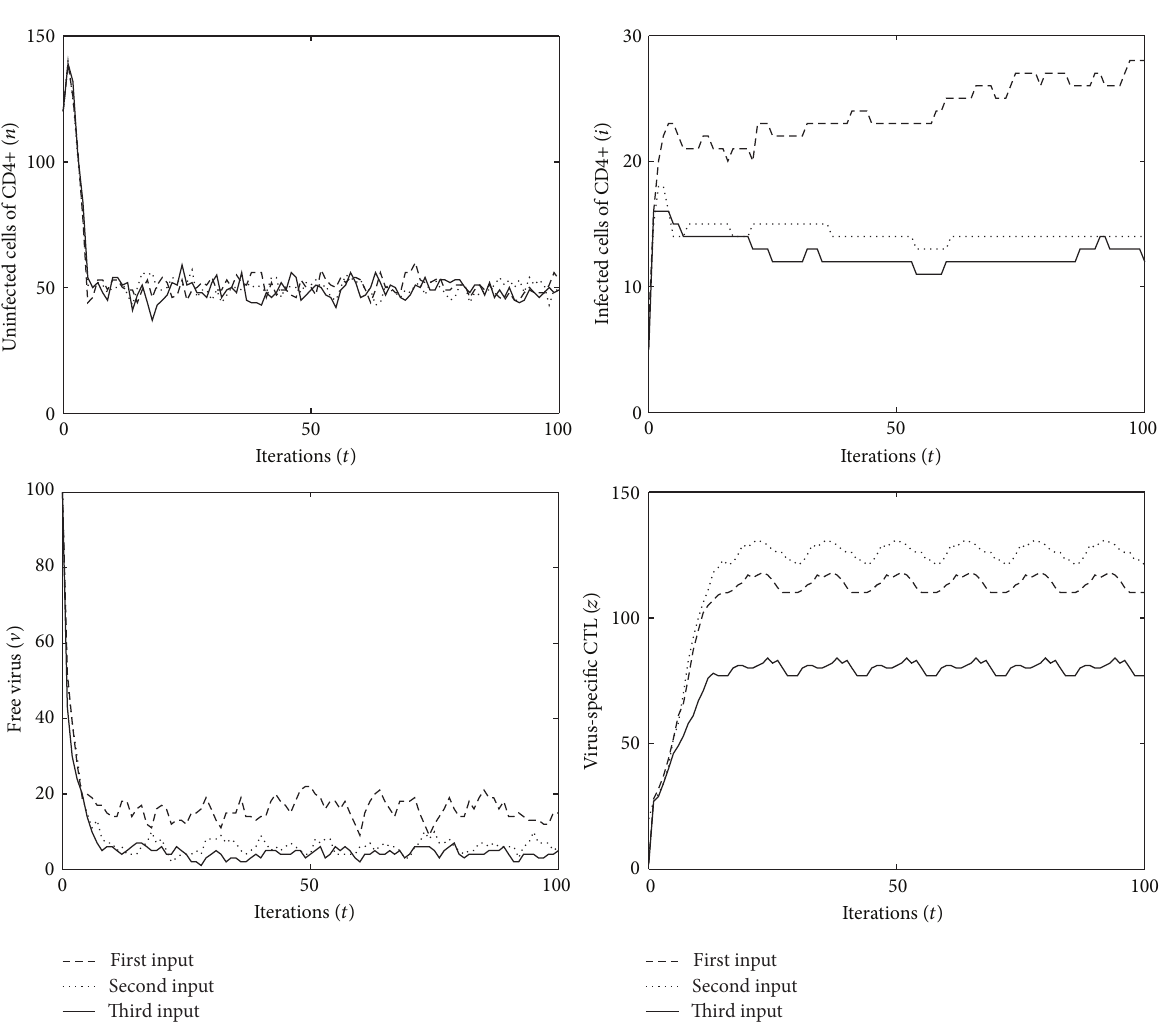
Figure 2: Results of cellular automaton simulation for the three